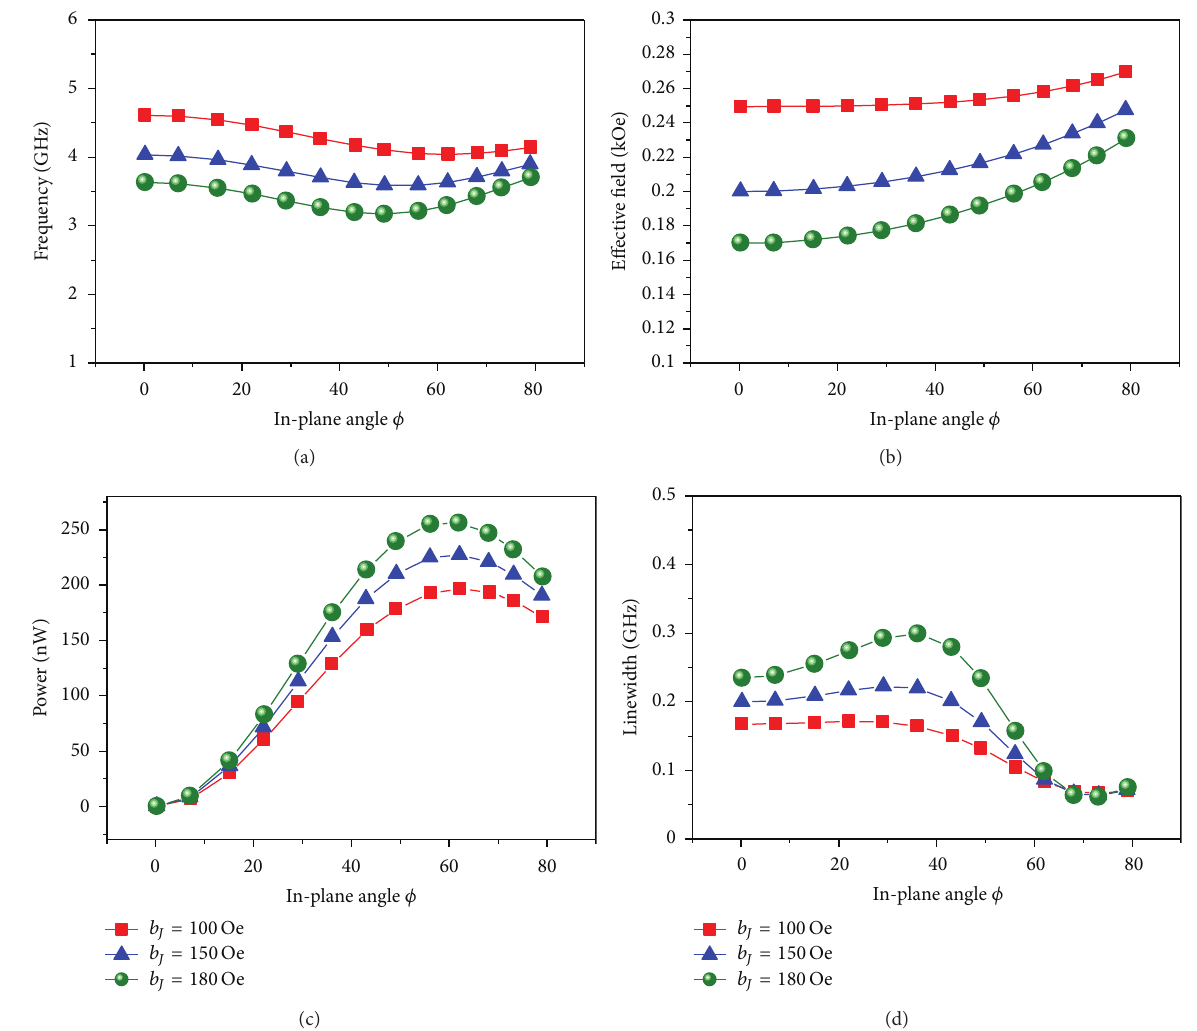
Figure 2: Characteristics of MTJ-STOs as functions of the perpendicular torque and the in-plane angle 𝜙 at 𝐼 = 1.5 mA. (a) Generation frequency, (b) effective field magnitude, (c) mean oscillation power and (d) generation linewidth.